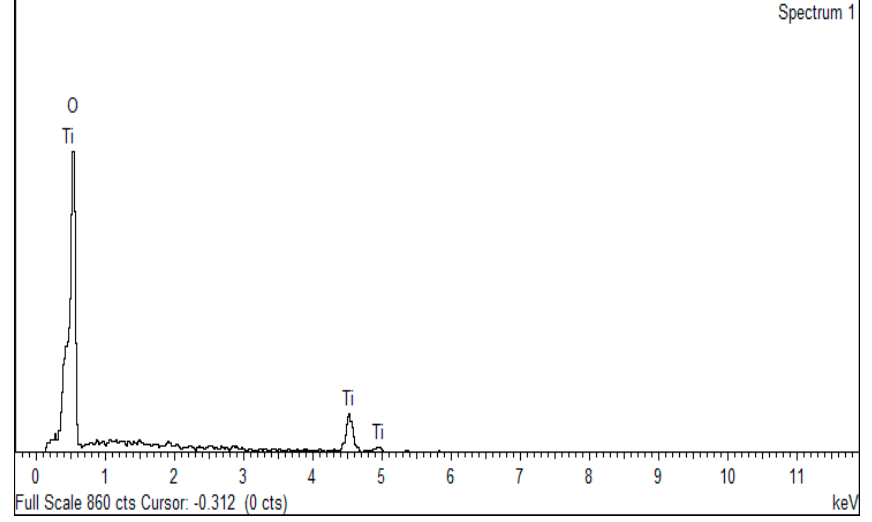
Figure 6. Energy-dispersive X-ray (EDX) results of TiO 2 -B 2 O 3 on the alumina substrate at T = 500 °C.